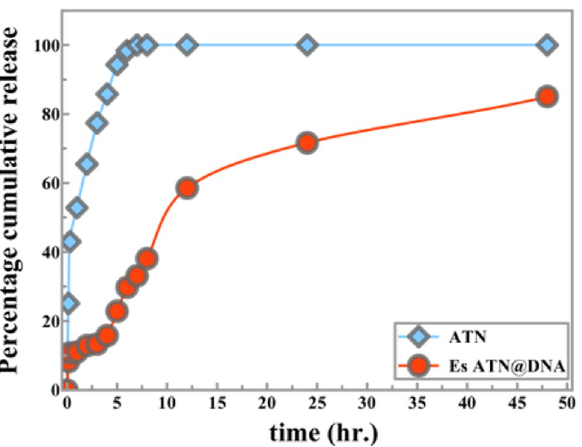
Figure 2. In vitro cumulative release profile of ATN and Es ATN@DNA in phosphate buffer saline pH